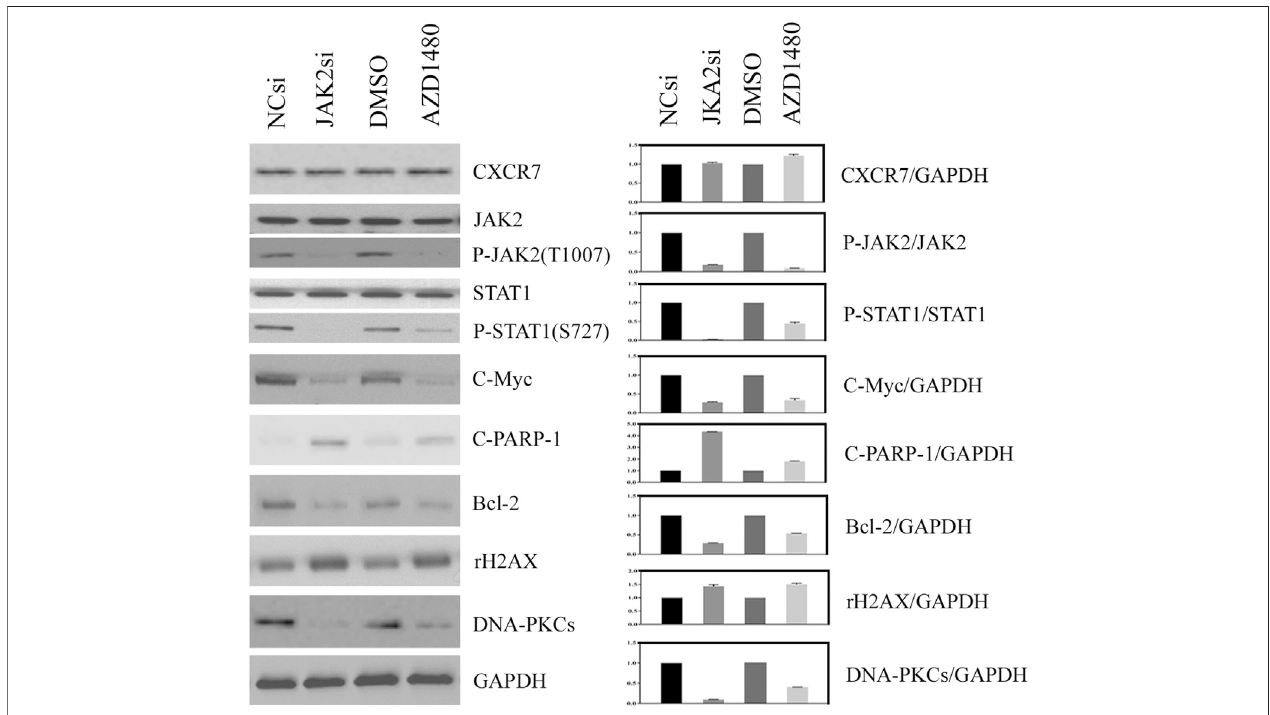
FIGURE 2 | Change pro fi le of downstream functional proteins after the inhibition of JAK2 activity. (A) Western blotting revealed that, after knocking down the expression of JAK2 by siRNA transfection and repressing the activity of JAK2 by AZD1480 in C4-2B cells, the expression ofCXCR7 did not display any change, but the expression of p-STAT1, oncogene C-Myc, and anti-apoptotic protein Bcl-2 decreased signi fi cantly. In addition, the expression of DNA damage marker γ H2AX increased, the expression of non-homologous end-joining (NHEJ) repairing protein DNA-PKCs signi fi cantly decreased, but the expression of homologous repairing (HR) protein C-PARP-1 increased. (B) All WB band densities were quantitatively